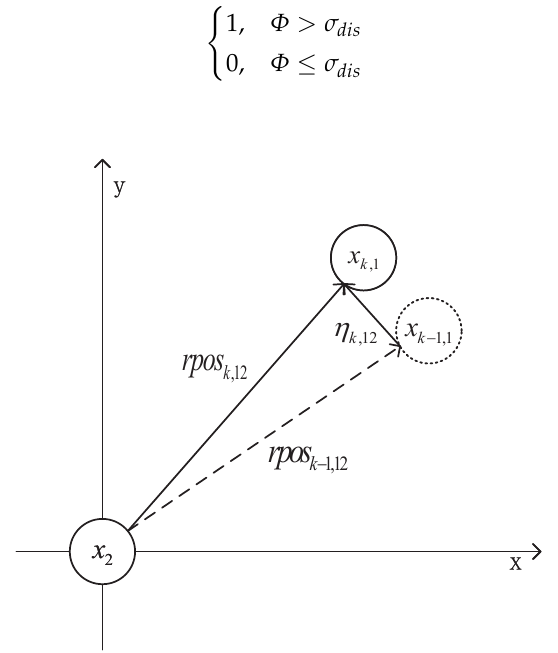
Figure 4. The schematic diagram of position deviation vector η k ,12 .